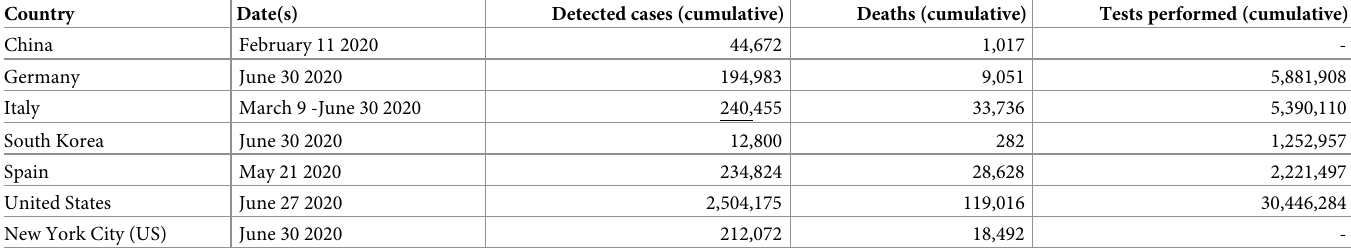
Table 1. Populations covered in the analysis, and their cumulative detected cases, deaths, and number of performed